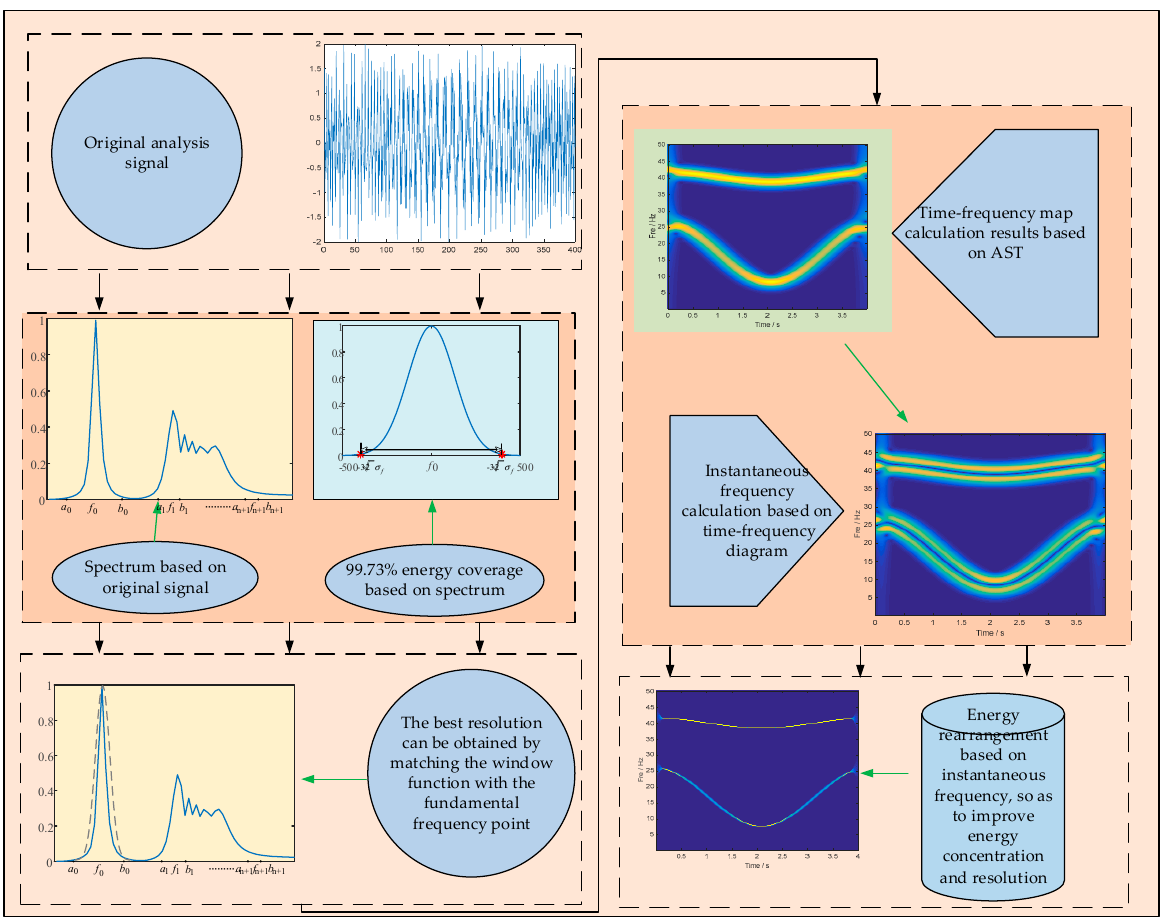
Figure 1. The schematic diagram of SAST.